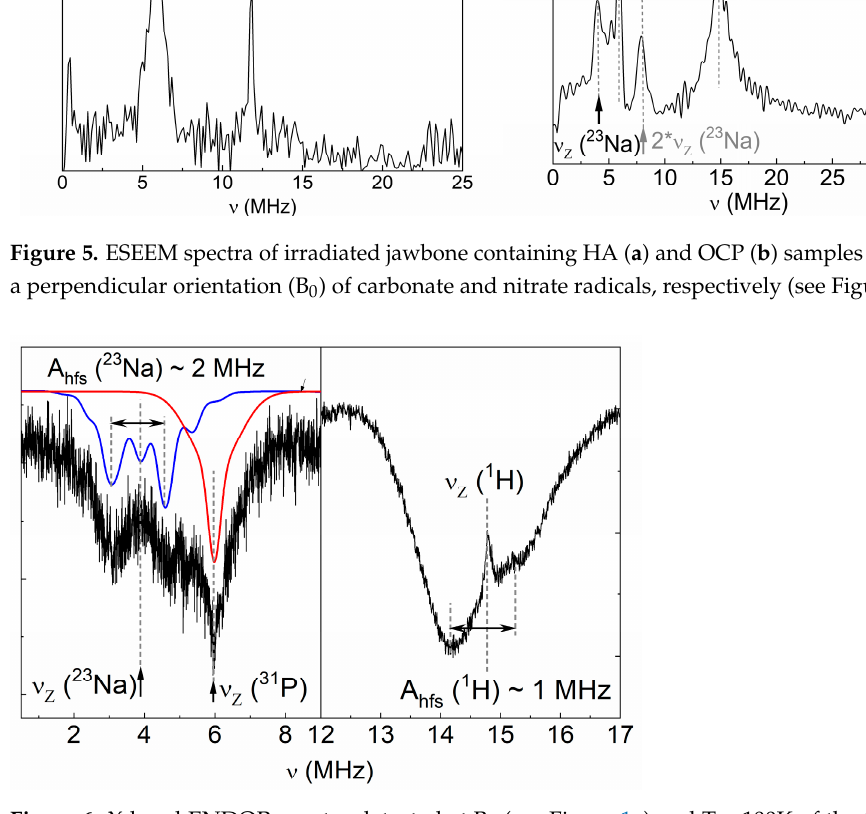
Figure 6. X-band ENDOR spectra detected at B 0 (see Figure 1a) and T = 100K of the OCP sample after X-ray irradiation.